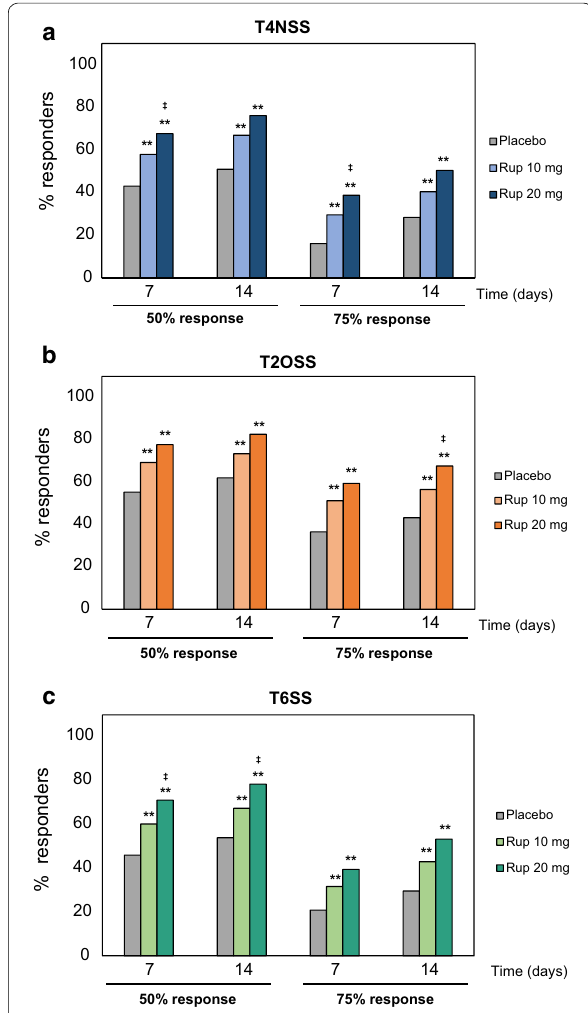
Fig. 2 Proportion of responders for the 50% or 75% response after treatment with rupatadine 10 mg or 20 mg for T4NSS, T2OSS, and T6SS. Data are expressed as percentage of patients achieving either a 50% or 75% reduction in symptom score from baseline (50% or 75% response, respectively) for: a T4NSS, b T2OSS, and c T6SS. Statistical significance was calculated with the Mann–Whitney test. * p < 0.05; ** p < 0.01 (rupatadine groups vs placebo); ‡ p < 0.05; ‡‡ p < 0.01 (rupatadine 10 mg vs rupatadine 20 mg). T4NSS Total 4 Nasal Symptom Score, T2OSS Total 2 Ocular Symptom Score, T6SS Total